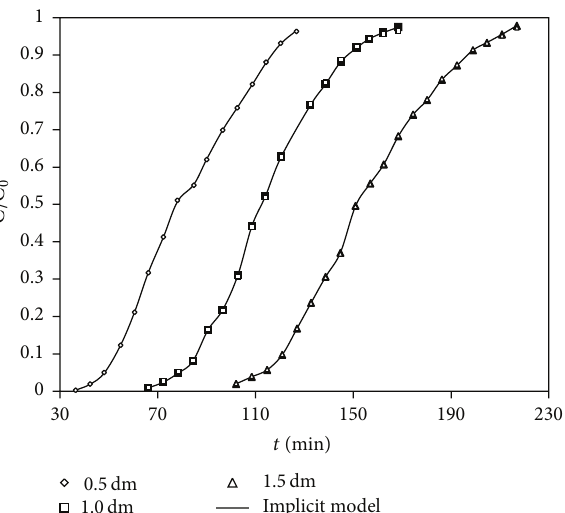
Figure 3: Breakthrough curves of Pb 2+ adsorption onto ETS-10 at different superficial velocity fitted with (2) [31]. Figure 4: Breakthrough curves of Cr(III) adsorption onto Agave lechuguilla biomass at different bed lengths fitted with (2)